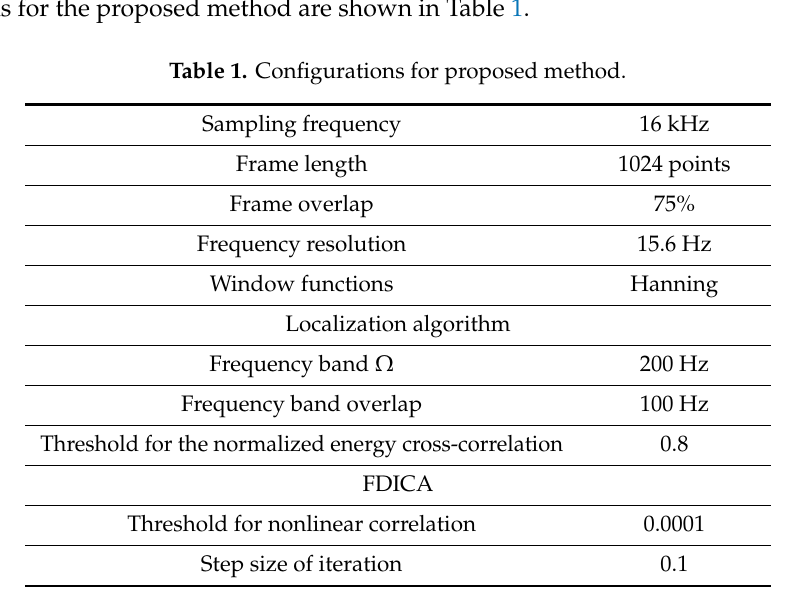
Table 1. Configurations for proposed method.